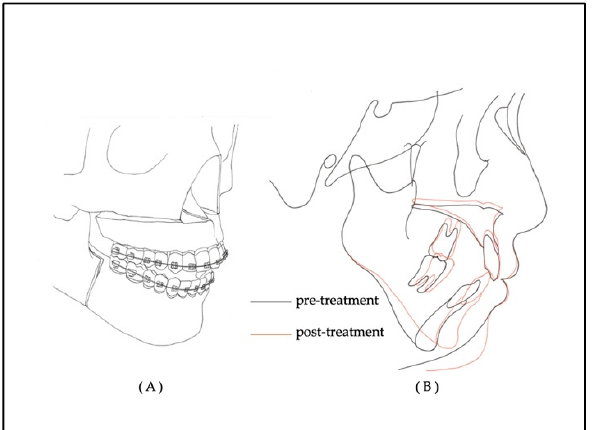
Figure 1. A schema of surgical orthodontic treatment. ( A ) Orthognathic surgery; Le Fort 1 osteotomy and sagittal split ramus osteotomy. ( B ) Superimposition of cephalometric trace changes pre- and post-treatment.